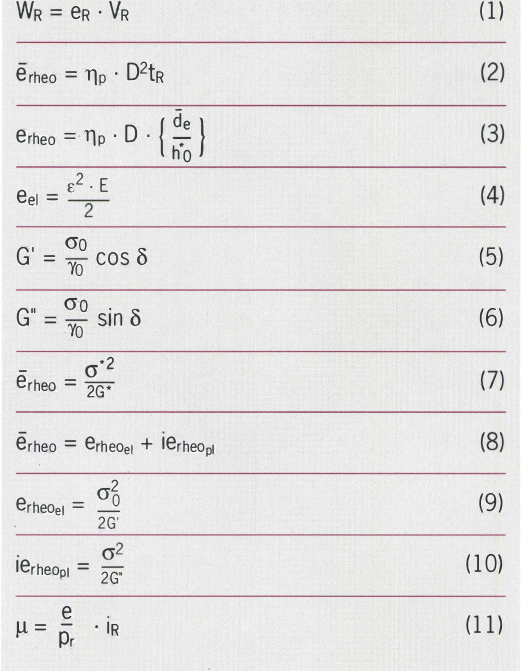
Fig. 2: Example from reference [9} of the energy density for different